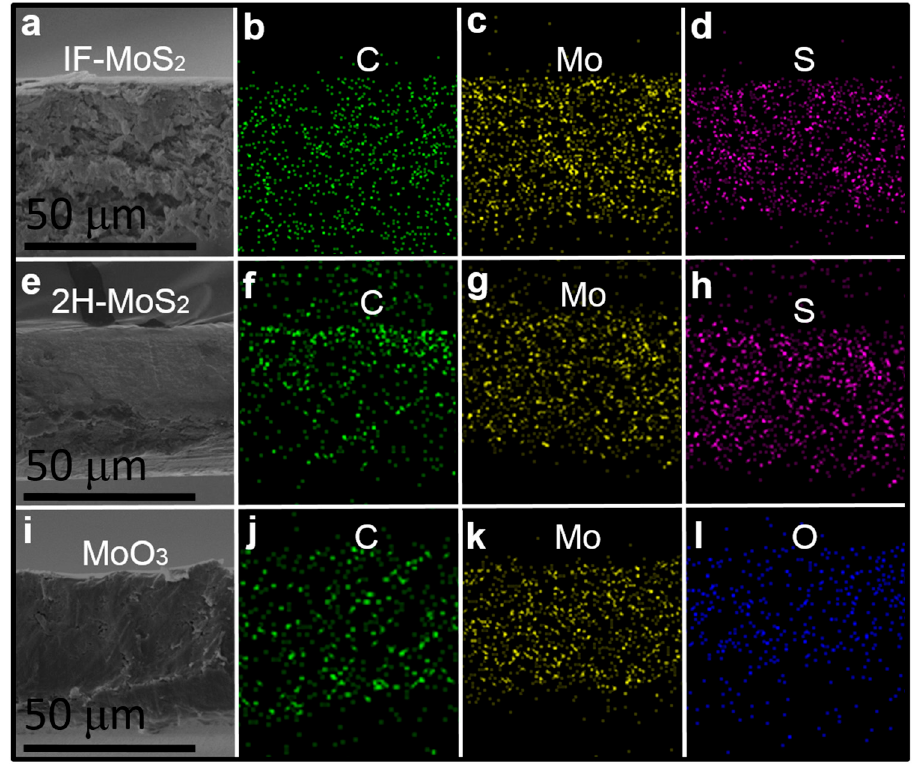
Figure 4. ( a ) SEM cross-sectional image with IF-MoS 2 NP additives; EDS mapping results of the ( b ) C signal, ( c ) Mo signal, and ( d ) S signal; ( e ) SEM cross-sectional image with 2H-MoS 2 NP additives; EDS mapping results of the ( f ) C signal, ( g ) Mo signal, and ( h ) S signal; ( i ) SEM cross-sectional images with